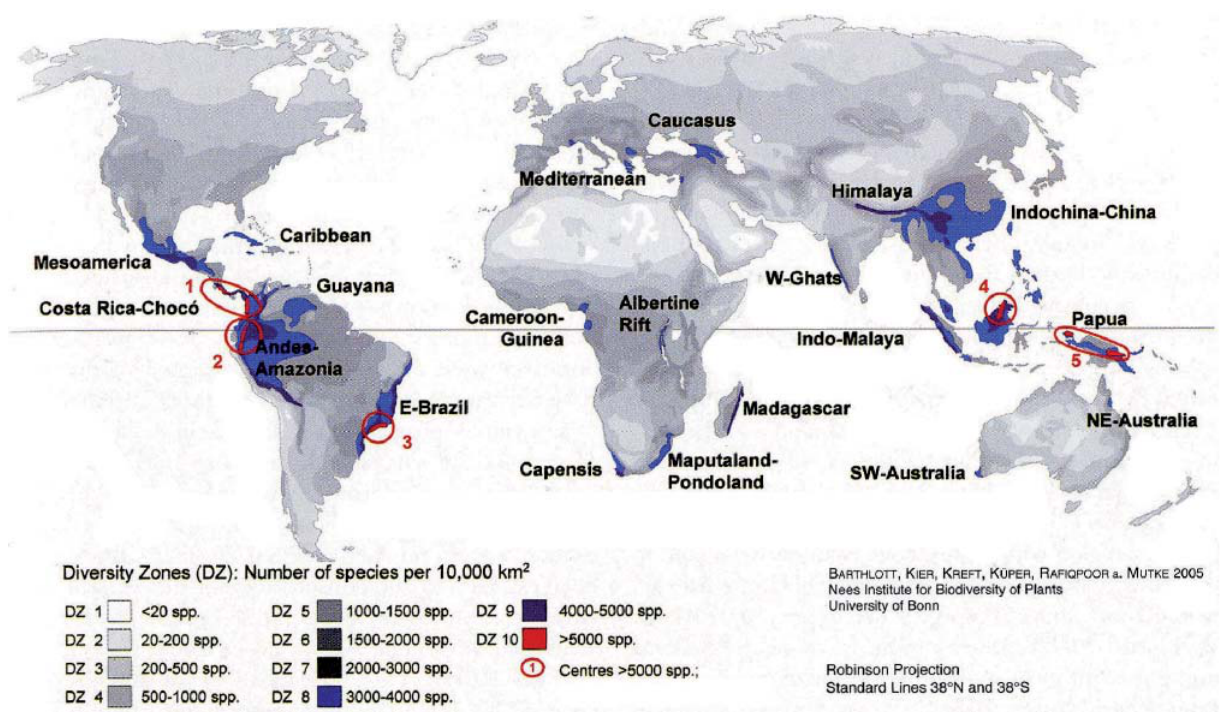
Figure 1: Map of vascular plant species richness. The research area (RBSF) is centered within one of the five world´s megadiversity hotspots. Apart from Ecuador the Costa Rica-Chocó area, south-eastern Brazil, nort- hern Borneo and the New Guinea mountain range are among the other hotspots. From: Barthlott et al.